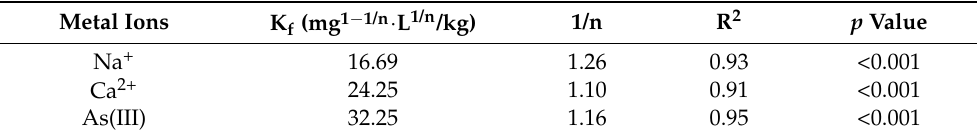
Table 6. Freundlich model for BPA on soil at different polyvalent metal ions conditions. Metal Ions